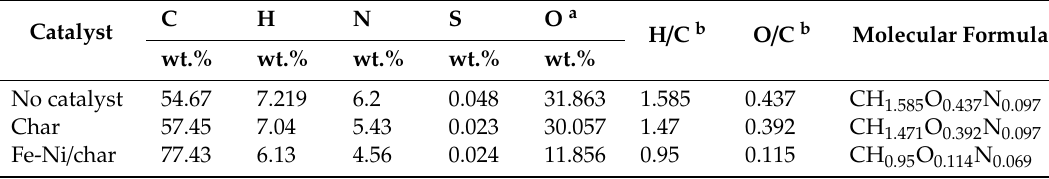
Table 3. Elemental analysis of tars from di ff erent